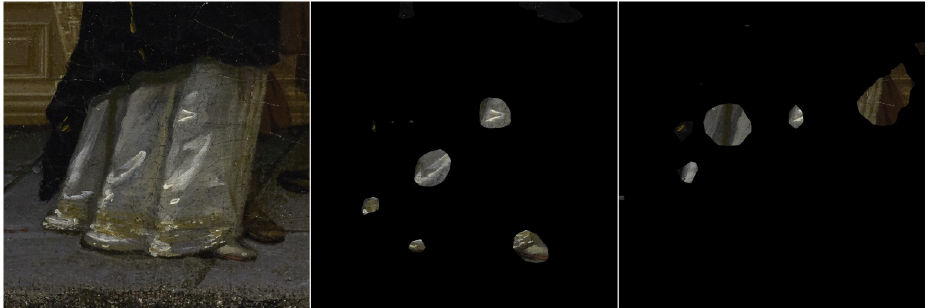
Fig 13. Visualization of cues used by classifiers. Left to right: Original Image, Masked Image (Painting Classifier), Masked Image (Photo Classifier). The unmasked regions represent evidence used by the classifiers for predicting “silk/ satin” in this particular image. See main text for details. Image from Interior of the Laurenskerk at Rotterdam , by Anthonie De Lorme, with figures attributed to Ludolf de Jongh , 1662. Digital image courtesy of the Getty’s Open Content Program, reproduced under a CC0